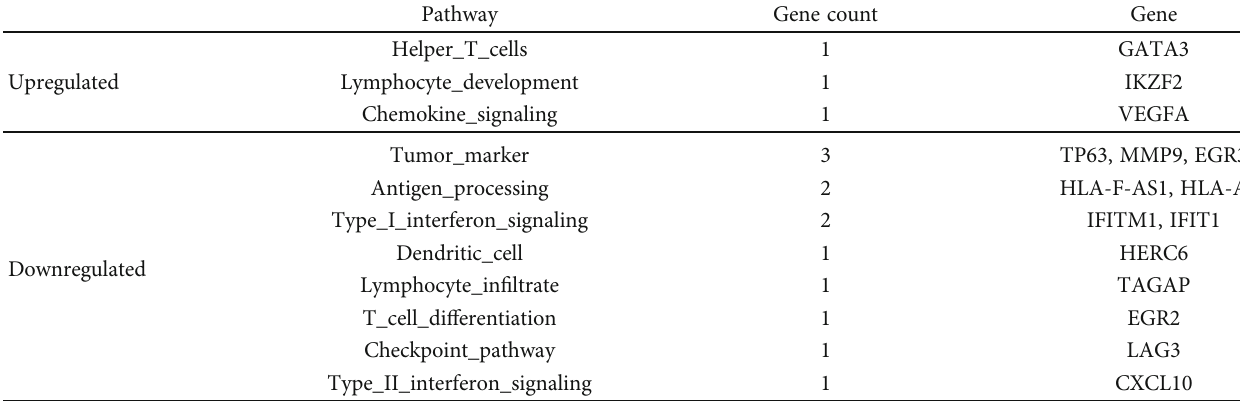
Table 3: Di ff erences of a gene in patients with di ff erent curative e ff ects before treatment.